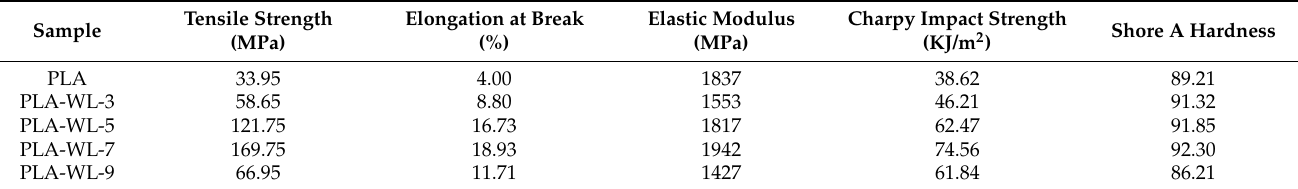
Table 2. The mechanical characteristics of the fabricated PLA ‐ WL biocomposites.